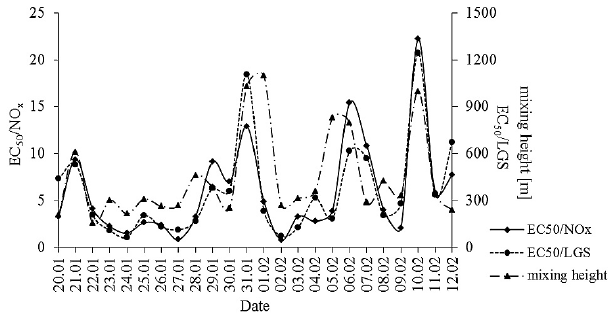
Fig. 2. Time series of the ratios of EC 50 /LGS [mgm 3 µg − 1 ] and EC 50 /NO x [mgm 3 µg − 1 ] in winter urban PM 10 in the period be- tween 20 January and 12 February 2010. The mixing heights are daily average